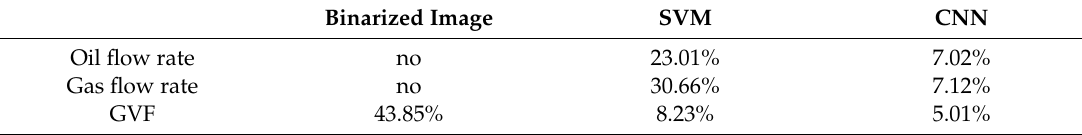
Table 2. Average relative error table of prediction of data before the venturi tube.